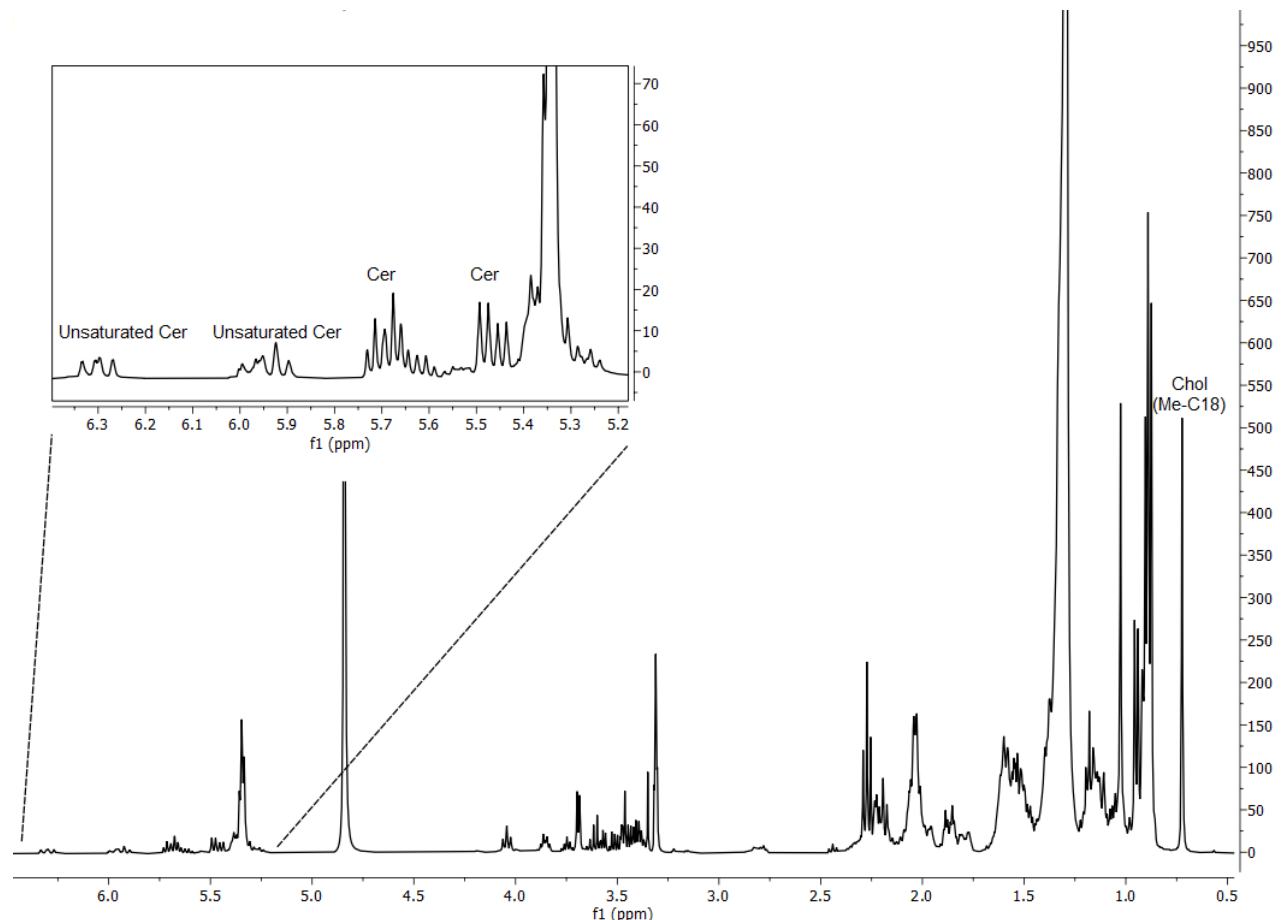
Figure 1. 1 H-NMR of Porphyromonas gingivalis raw lipid extract. Signals relative to ceramides (Cer) and total cholesterol (Chol) are highlighted.